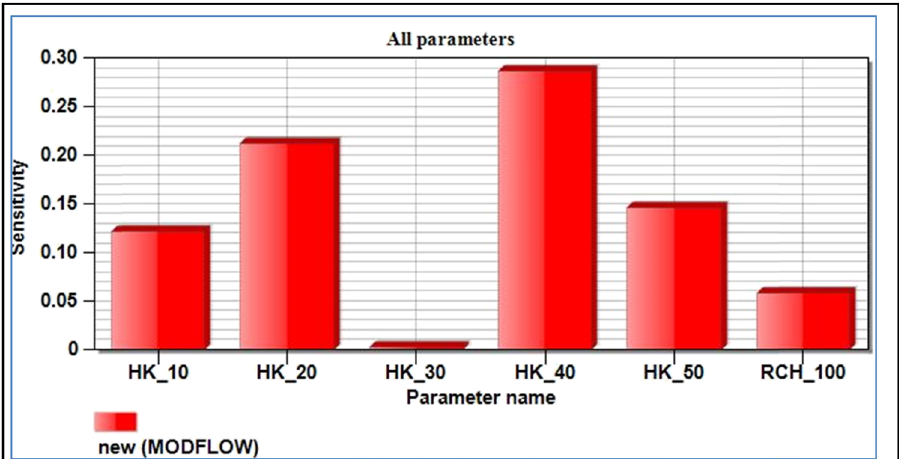
Figure 6: Hydraulic conductivity and recharge sensitivity results.